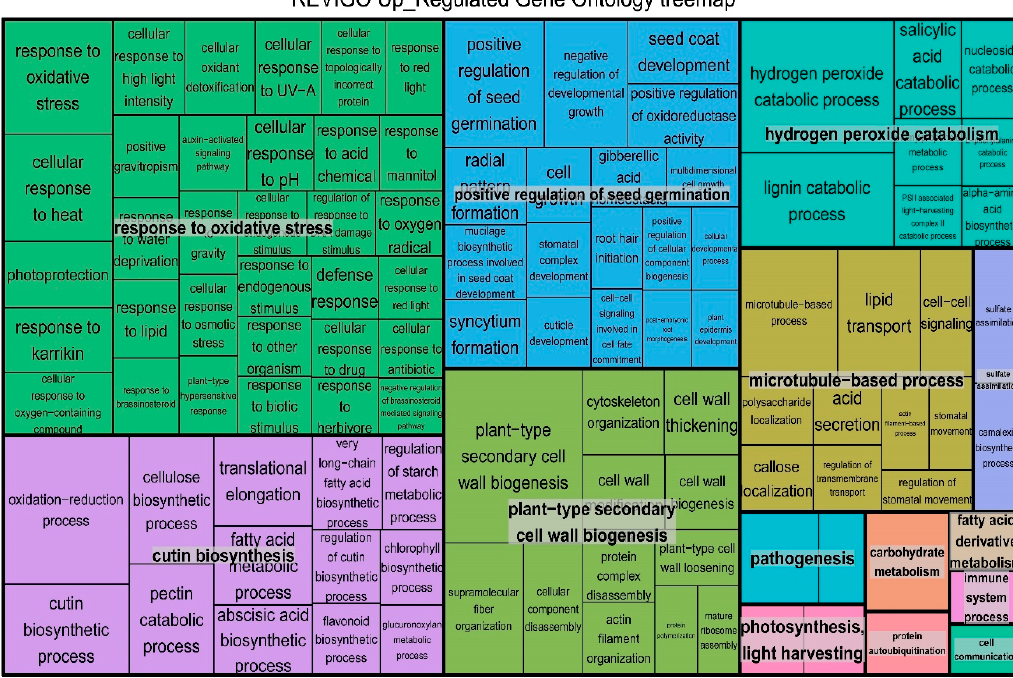
Figure 3. REVIGO analysis results for genes upregulated in B. distachyon under salt stress. Each rectangle is a single cluster representative. The representatives are joined into “superclusters” of loosely related terms and visualized with different colors. The sizes of the rectangles were adjusted to reflect the p -value of the GO terms calculated by TopGO. In this study, 182 upregulated processes were integrated into 14 groups.